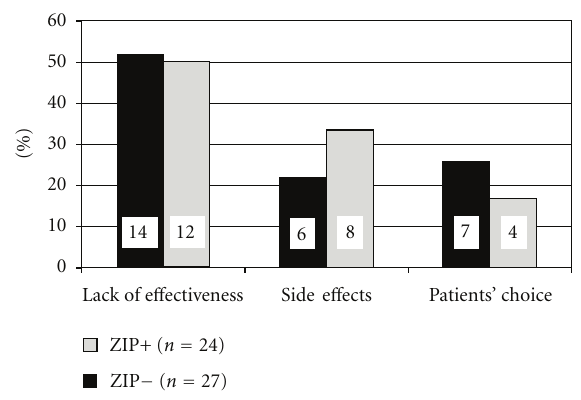
Figure 1: Main reasons for a switch from or to ziprasidone ZIP − , switch from ziprasidone; ZIP+, switch to